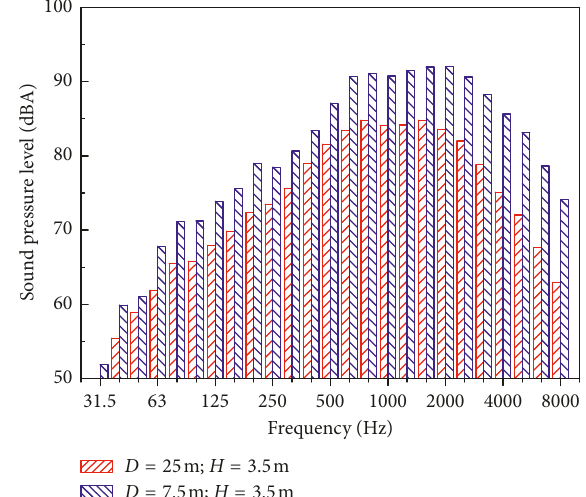
Figure 4: Frequency characteristics of the pass-by noise at different measurement points (350km/h).